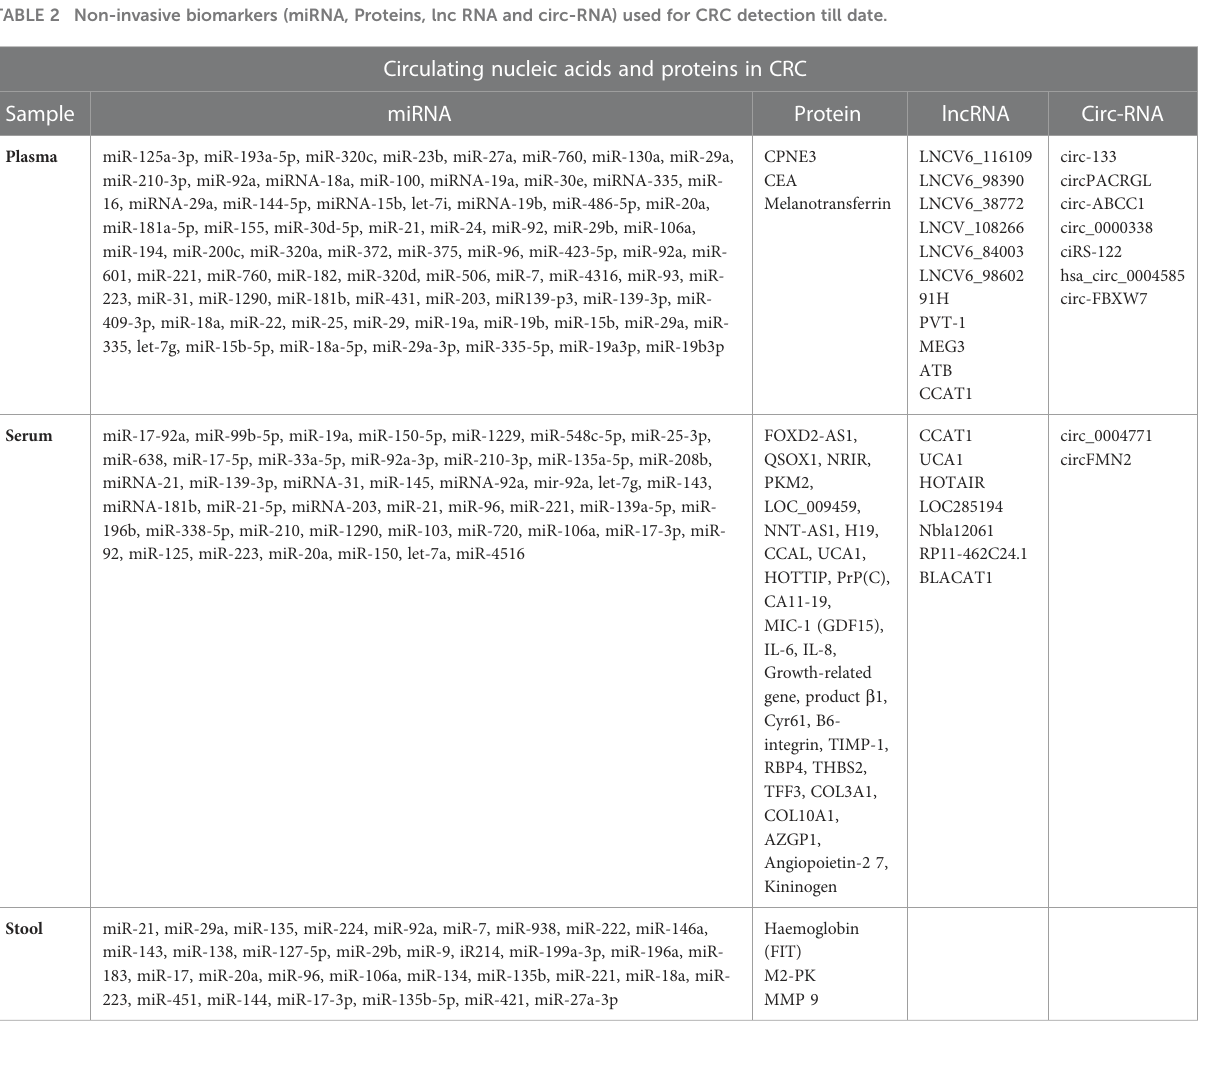
TABLE 3 Non-inavsive Protein and miRNA Panel used for CRC detection.